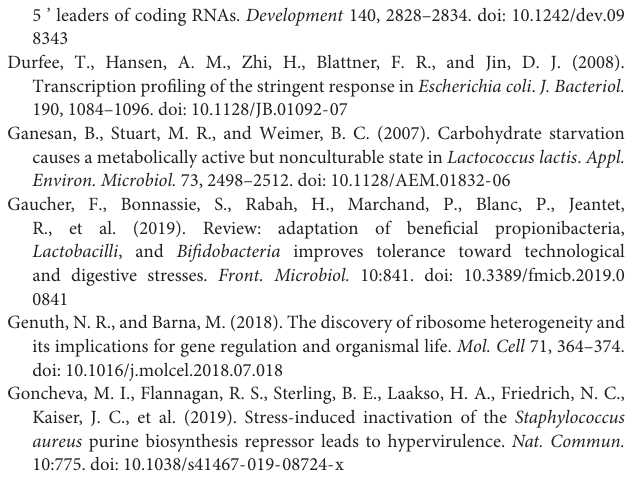
Supplementary Figure 1 | Effects of different sodium lactate concentration on the growth of L. rhamnosus ATCC 53103. (A) Growth curve of L. rhamnosus ATCC 53103 under different sodium lactate concentration. (B) The viable count of L. rhamnosus ATCC 53103 under different sodium lactate concentration. Supplementary Figure 2 | Overview of experimental design. RNA-seq and ribosome profiling were performed on CG and OS. Supplementary Figure 3 | Correlation of gene expression of mRNA abundance with Ribo-seq abundance of OS. Supplementary Figure 4 | Correlation of gene expression of mRNA abundance with gene translation efficiency of